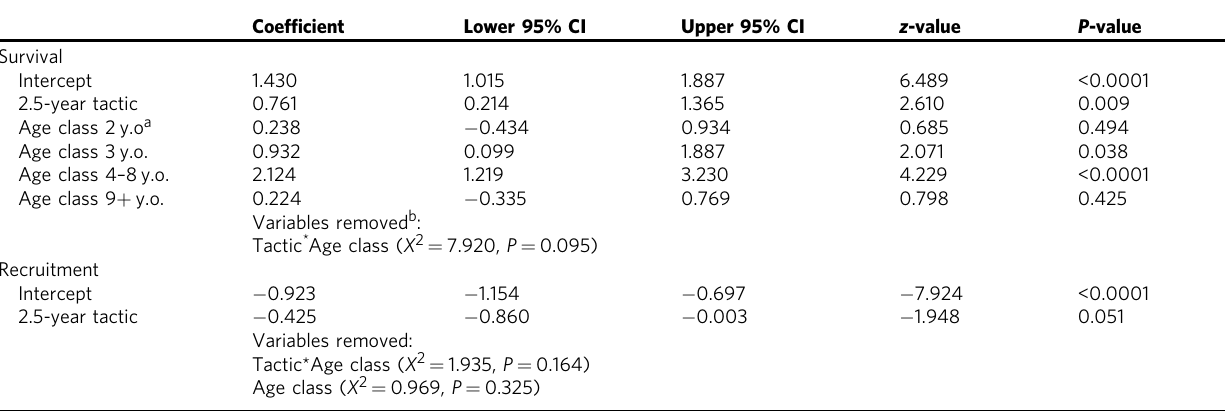
Table 1 Parameter estimates from fi nal statistical models comparing tactic- and age class-speci fi c demographic rates for female brown bears in south-central Sweden from 1993 to 2015 Coef fi cient